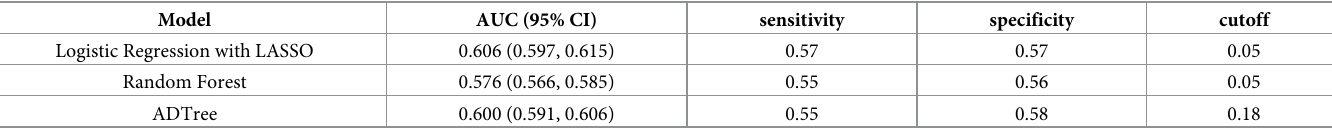
Table 4. Comparison of model fits (by 10-fold cross-validation) to predict the injury recurrence (at any time point after, ignoring time-to-event and censoring).